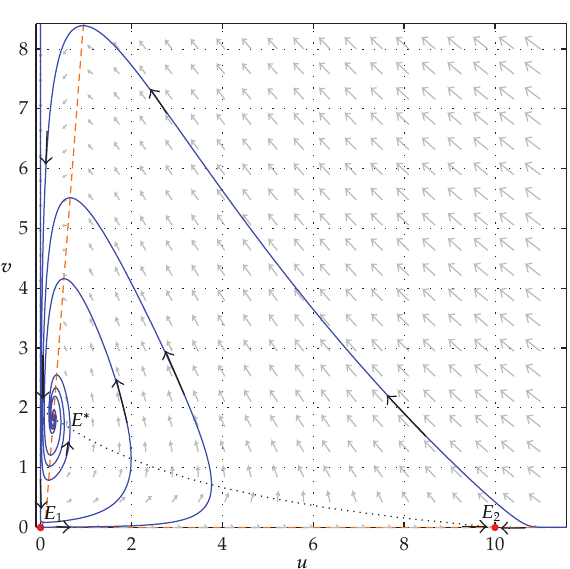
Figure 1: The phase portrait of model (cid:6) 1.7 (cid:7) without the di ff usion and delay e ff ects, that is, τ (cid:5) 0, d 1 (cid:5) d 2 (cid:5) 0. The other parameters are taken as α (cid:5) 2, β (cid:5) 0 . 2, γ (cid:5) 0 . 5, b (cid:5) 2, and c (cid:5) 3, m (cid:5) 1. In this case, E 1 (cid:5) (cid:6) 0 , 0 (cid:7) and E (cid:5) (cid:6) 10 , 0 (cid:7) are saddle points; the unique positive equilibrium E ∗ (cid:5) (cid:6) 0 . 6623 , 1 . 6491 (cid:7) is globally 2 asymptotically stable. The dashed curve is the u -nullcline u (cid:6) α − βu (cid:7) − cuv/ (cid:6) mv (cid:8) 1 (cid:7) (cid:5) 0, and the dotted curve is the v -nullcline v (cid:6) − r (cid:8) bu/ (cid:6) mv (cid:8) 1 (cid:7)(cid:7) (cid:5)